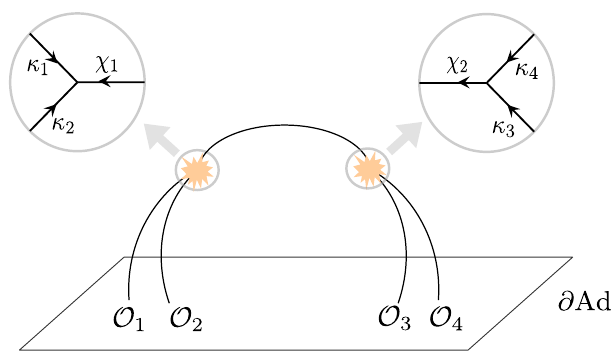
Figure 10. Geodesic network. The contribution from the pole c = ∆ b corresponds to a network of geodesics in which the conservation of momenta holds at each vertex. Here χ 1 , 2 are internal vertex momenta while κ j ’s are external vertex